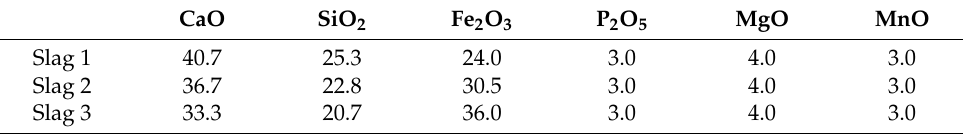
Table 1. Composition of dephosphorization slag with different Fe 2 O 3 content (mass%). CaO SiO 2 Fe 2 O 3 P 2 O 5 MgO MnO Slag 1 40.7 25.3 Slag 2 36.7 Slag